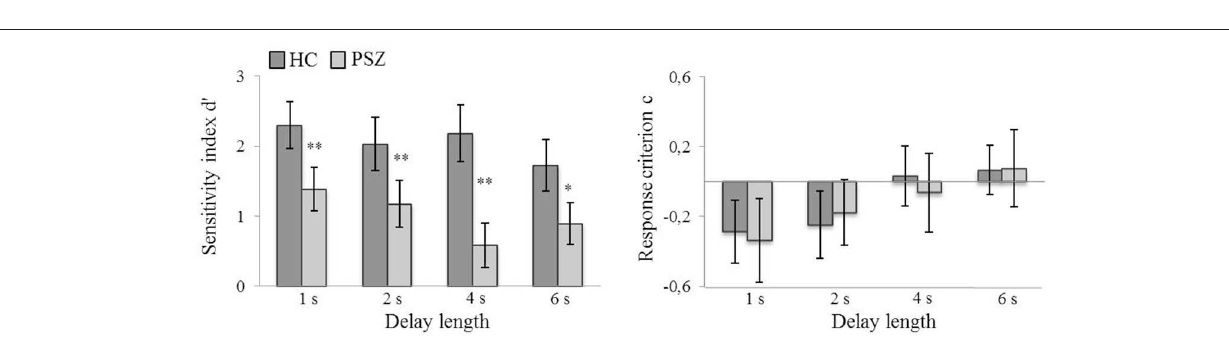
FIGURE 4 | Sensitivity (d ′ ) and response criterion (c) at different delay lengths in patients with schizophrenia (PSZ) and healthy controls (HC). Error bars represent the standard error of the mean. Significant group differences at different delay lengths are marked. *indicates p < 0.05 and **indicates p < 0.01, corrected for multiple comparisons. Error variances were equal across groups for all delay lengths (Levene’s test, p > 0.05). Participants’ response strategy changed from more liberal (i.e., negative values signify a bias toward responding match) to more conservative (i.e., positive values signify a bias toward responding non-match) with longer delay